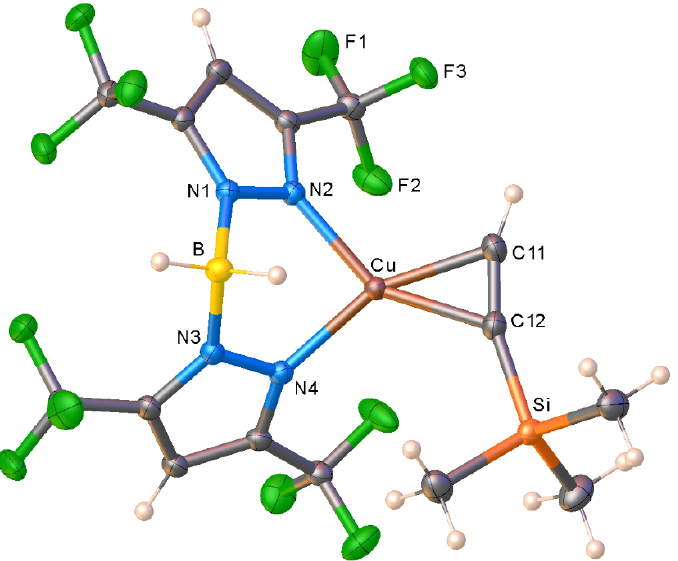
Figure 3. Molecular structure of [H 2 B(3,5-(CF 3 ) 2 Pz) 2 ]Cu(HC ≡ CSiMe 3 ) ( 5 ); ORTEP view with 50% probability ellipsoids are shown. Selected bond distances (Å) and angles (°): Cu-N2 1.9857(9), Cu-N4 1.9845(9), Cu-C11 1.9600(12), Cu-C12 1.9957(11), C11-C12 1.2343(17), B-N1 1.5778(15),